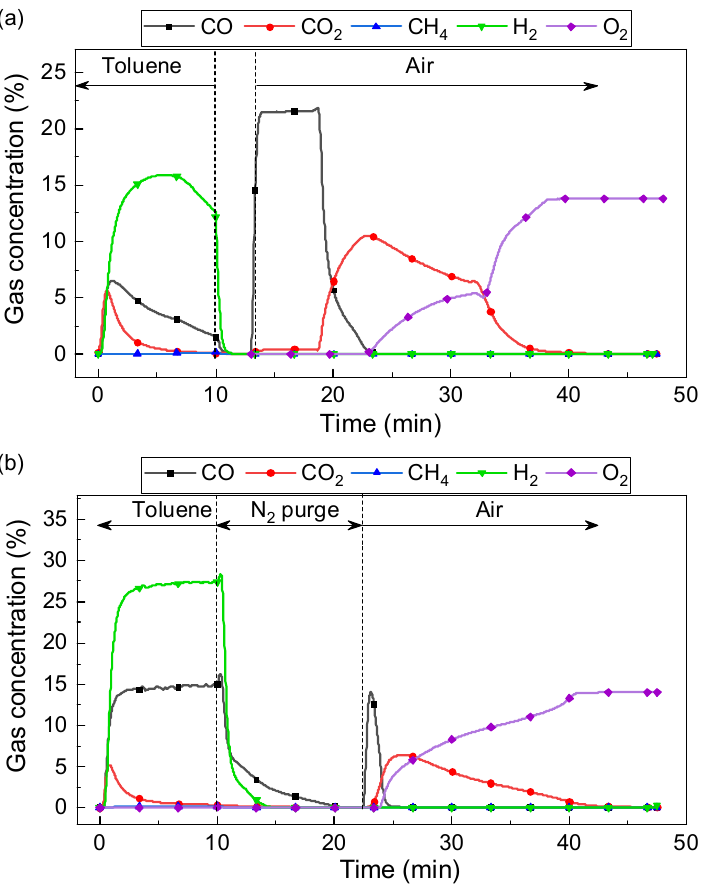
Figure 10. Gas production during chemical looping conversion of toluene using LaFe 0.4 Ni 0.6 O 3 at 900 °C: ( a ) In the absence of H 2 O, ( b ) In the presence of H 2 O.